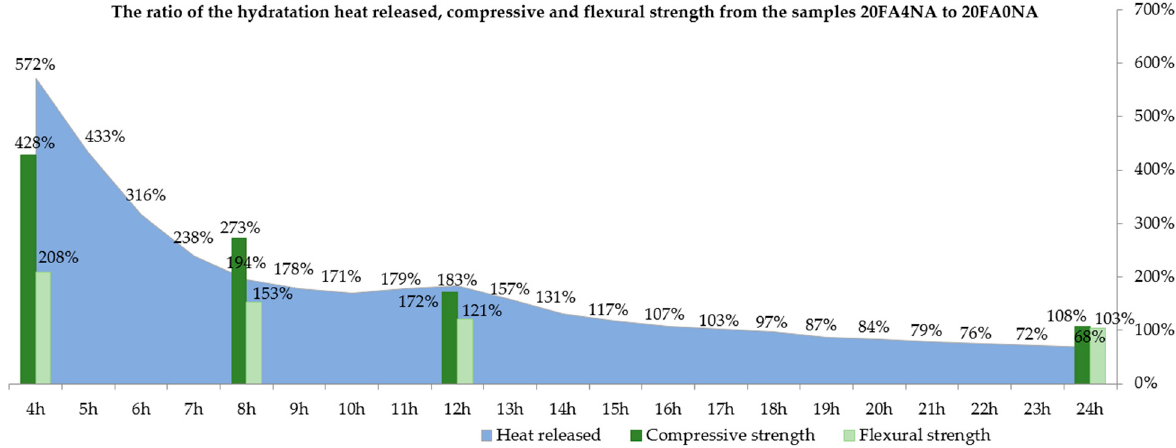
Figure 3. The percentage increase in the amount of heat released as well as f cm and f ctm over time. When analyzing the obtained results, it is clearly visible that the NA, after 4 h, caused an increase in the amount of heat released almost 5 times. This means that both in the space of the cement grains and in the voids (which was helped by the NA), a reaction took place and the formation of crystalline phases, mainly silicate gel. The use of NA allowed for a more effective use of both the cement itself and, additionally, the use of free spaces between the grains to create a compact and durable structure. A much greater amount of heat released in the NA-modified samples is visible during the first 16 h of the mixture curing. The strength increase in this period is also confirmed by the previously conducted strength tests of the pastes (Tables 7 and 8). This tendency is clearly visible in Figure 3. The graphs of heat released over time, in the case of NA modified samples, apart from changes in values, also have changes in the characteristic curve for the binding.